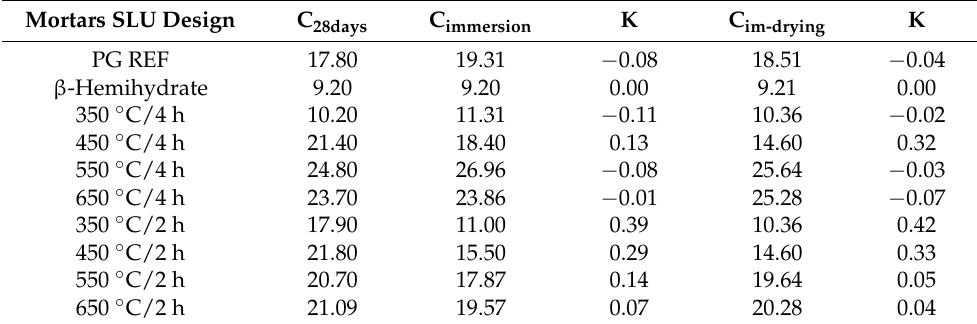
Table 9. Compressive strength of self-leveling underlayments after 28 days (C 28days ) and after 28 days of immersion (C immersion ) and immersion-drying (C im-drying ) cycles.